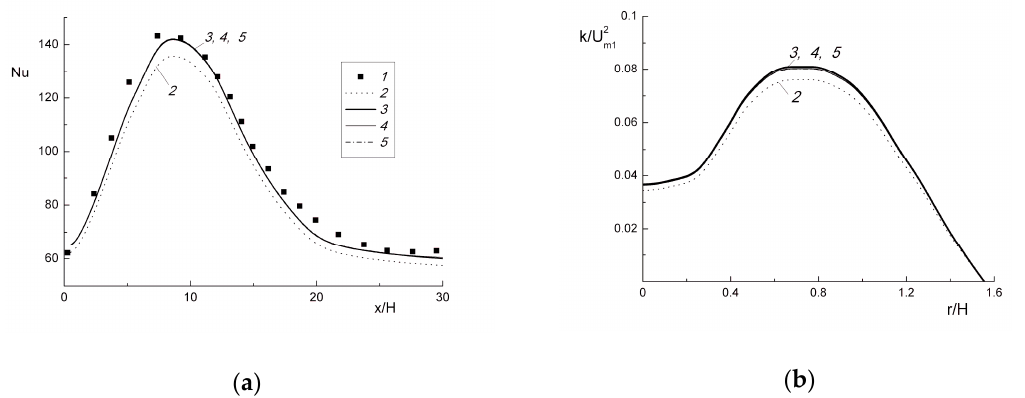
overlap each other over the pipe radius.